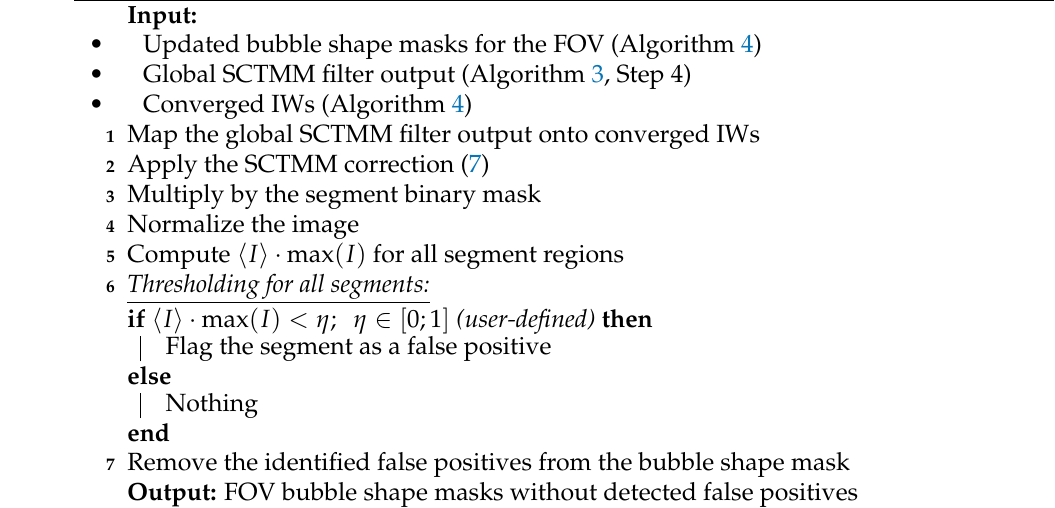
Algorithm 6: Luminance map-based false positive filtering for MRIF